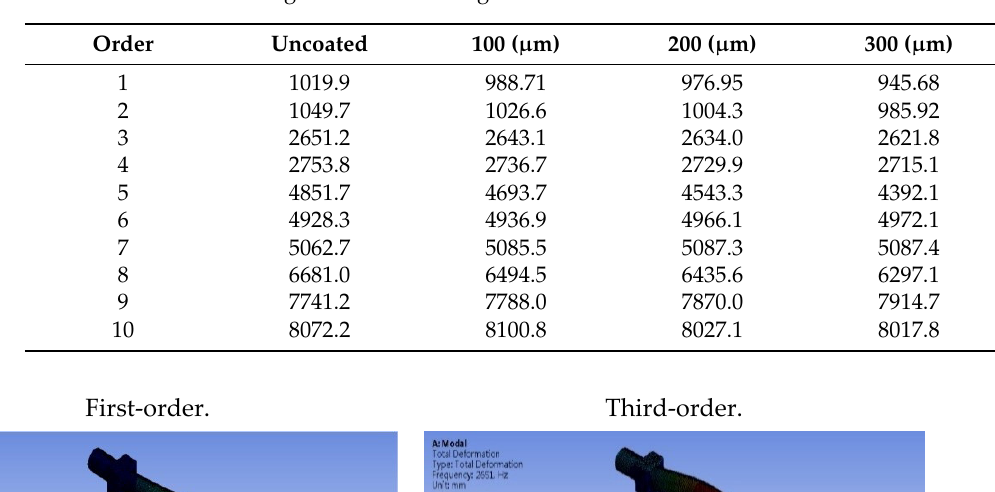
Table 6. Natural frequency (Hz) of the TA18 titanium alloy straight aviation hydraulic pipe coated Figure 4. Model meshing ( a ) without the hard coating and ( b ) with the hard coating. with the YSZ–PTFE coating at different coating thicknesses.